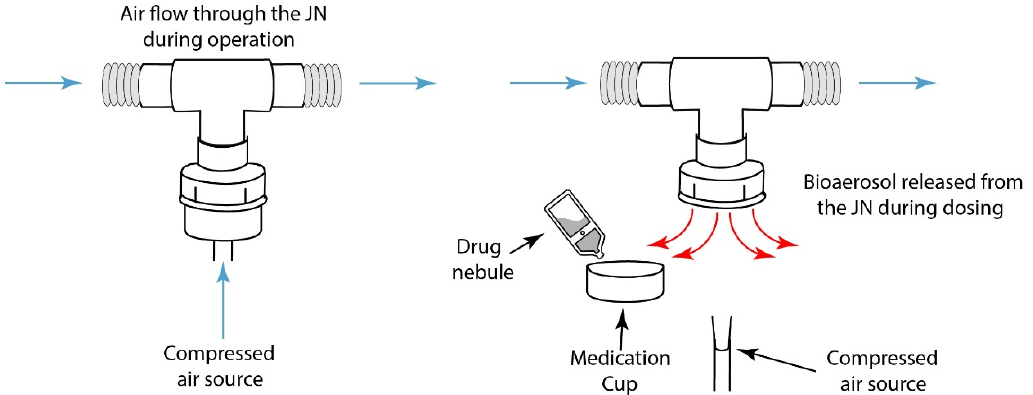
Figure 3. Drug refill process for a jet nebuliser (JN) which results in an open ventilator.